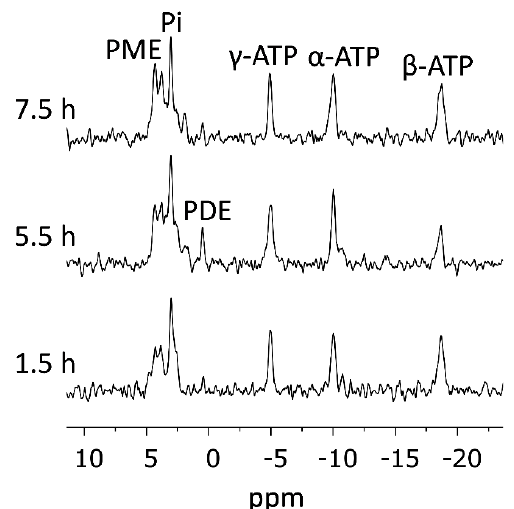
Figure 2. 31 P-NMR spectra acquired from viable breast cancer tumor slices continuously perfused in the NMR spectrometer. Acquisition of the first spectrum started after a recovery period of 0.5 h in the NMR tube, in the spectrometer. The time scale marks the end of the acquisition of each spectrum with reference to the time the slices were placed in the NMR tube. The spectra were acquired with a 50° nutation angle, a repetition time of 1.12 s, and 8192 points. Each spectrum is the sum of two 34 min acquisitions (3600 excitations in total). The spectra were processed with a line-broadening of 15 Hz, zero-filled to 16,384 points, and baseline corrected. PME, phosphomonoesters, typically consisting of phospho-ethanolamine and phosphocholine; Pi, inorganic phosphate; PDE, phosphodiesters; ATP, adenosine triphosphate. The chemical shift was referenced to α -ATP at -10.03 ppm. In this particular example, between 1.5 and 4 h there were 2 injections of hyperpolarized pyruvate (a total of 1.07 mM were added to the perfusion medium) and between 5.5 and 6.5 h the perfusion medium was enriched with choline chloride (1.06 mM), which is likely the reason for the increase in the PME signal in the spectrum acquired at 7.5 h.